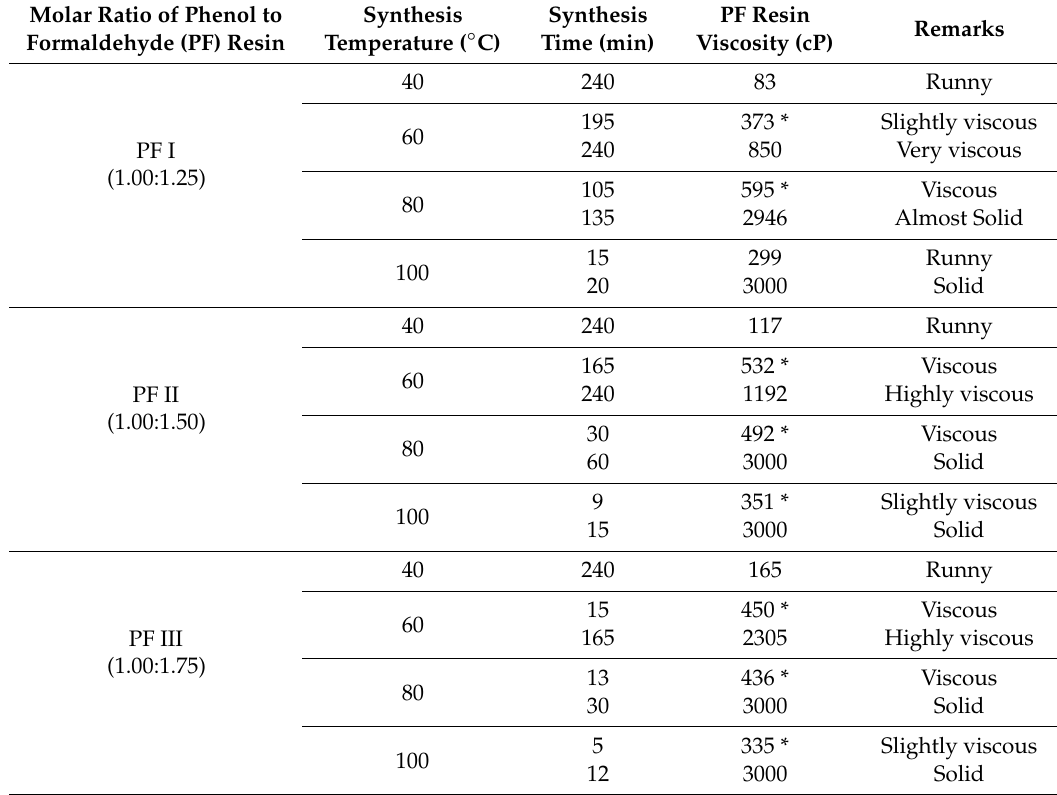
Table 2. Synthesis time with the viscosity of PF